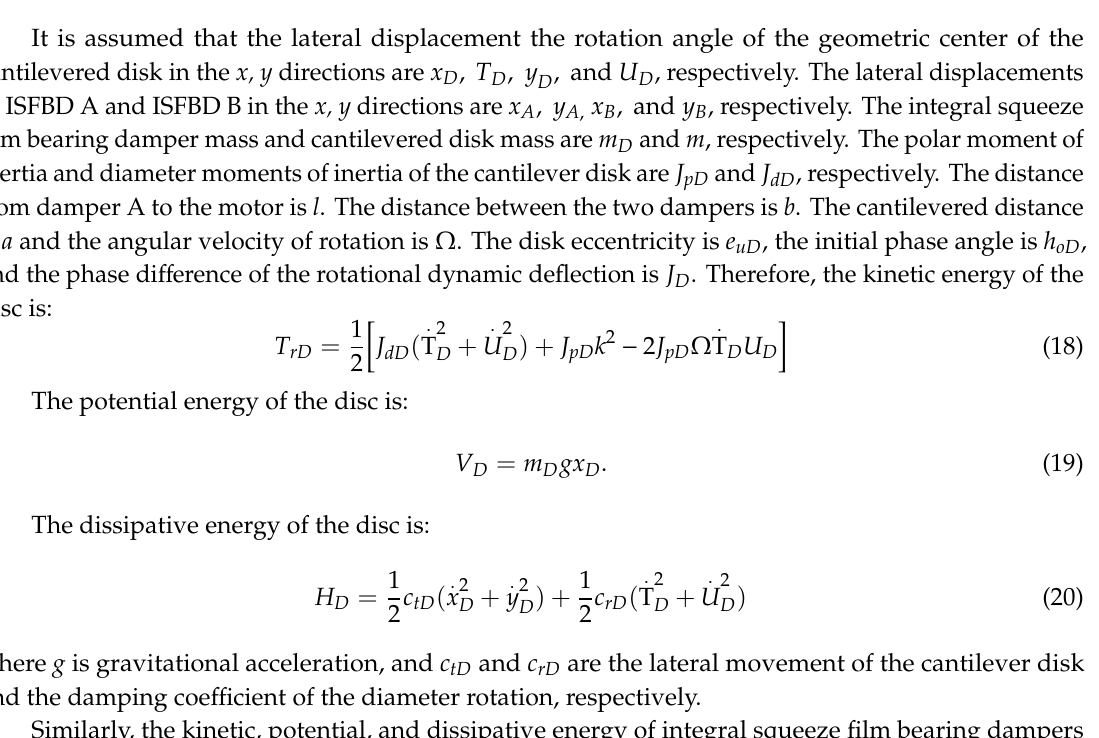
Figure 4. Dynamic model of single-side cantilevered rotor system.